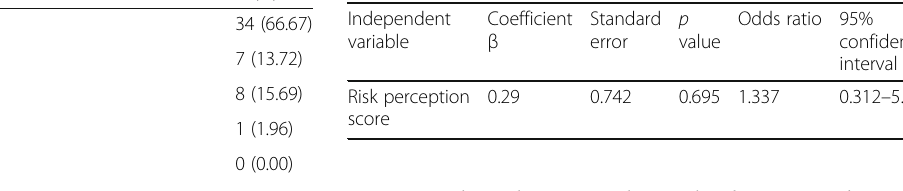
Table 6 Results of logistic regression analysis for assessing the relationship between risk perception score and occupational accident occurrence of foundry workers in Tehran, Iran, 2016